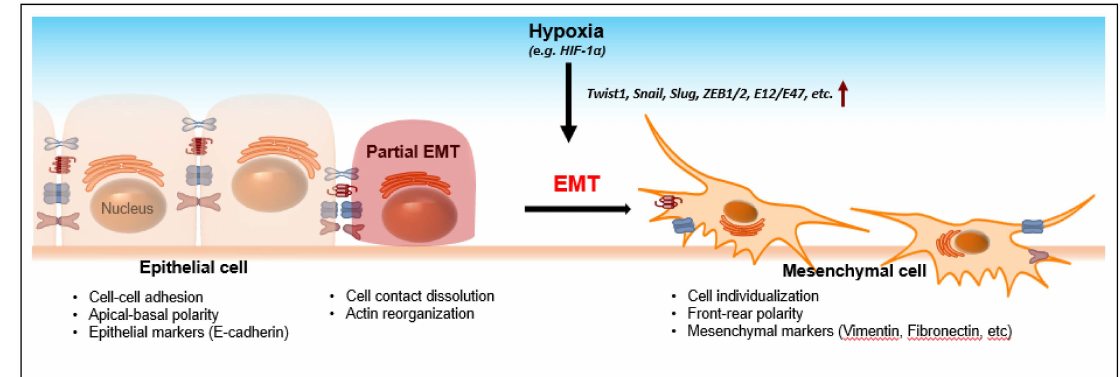
Figure 2. The epithelial-mesenchymal transition (EMT). The process of EMT requires loss of cell-cell contact, apical-basal polarity, and adhesion molecules (e.g., E-cadherin). Transformed epithelial cells then gain front-rear polarity and dissociate from the neighboring cells with increased expressions of mesenchymal markers. Thus, EMT increases cell motility which facilitates invasion and metastasis during cancer progression. Hypoxia is one of the driving forces that facilitate EMT. During hypoxia, many transcriptional regulators that govern the expressions of E-cadherin are activated by HIF-1 α . As a result, downregulation of E-cadherin facilitates the development of mesenchymal phenotypes, leading to invasion and